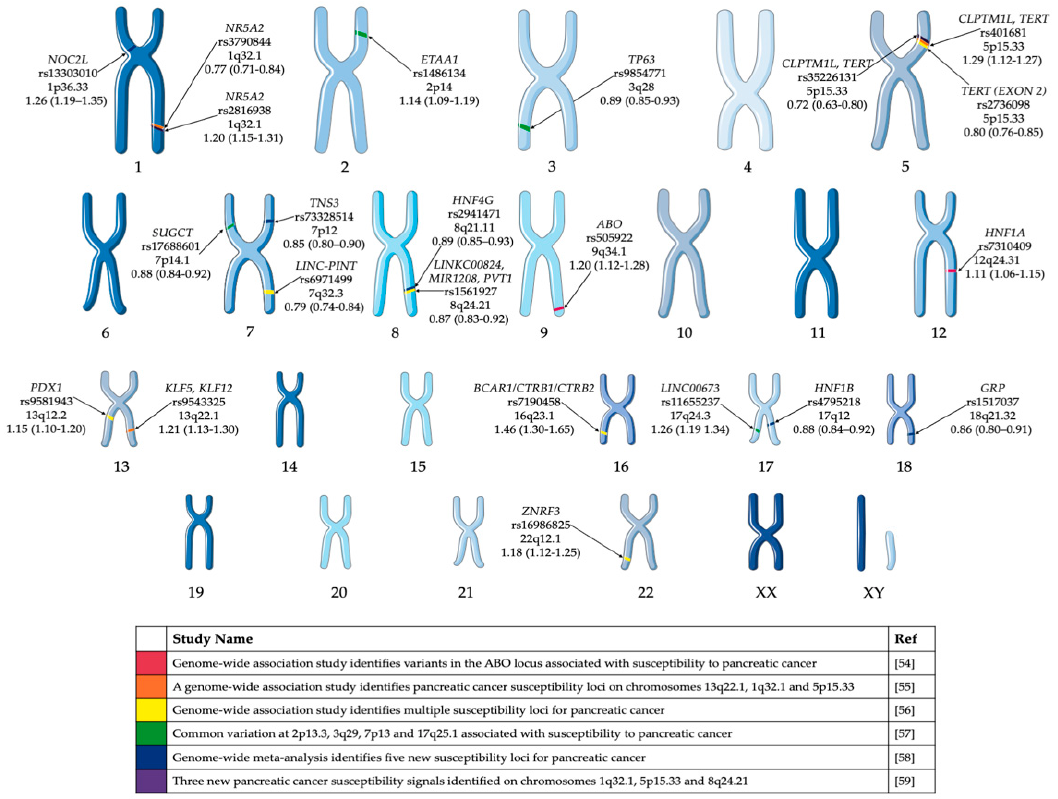
Figure 1. GWAS significant single nucleotide polymorphisms (SNPs) identified in pancreatic cancer cases of European ancestry. Highlighted GWAS SNP, closest gene, chromosome and odds ratio (95% confidence interval) [54–59]. This figure was created using Servier Medical Art templates, which have been modified. These images are licensed under a Creative Commons Attribution 3.0 Unported License; https://smart.servier.com.